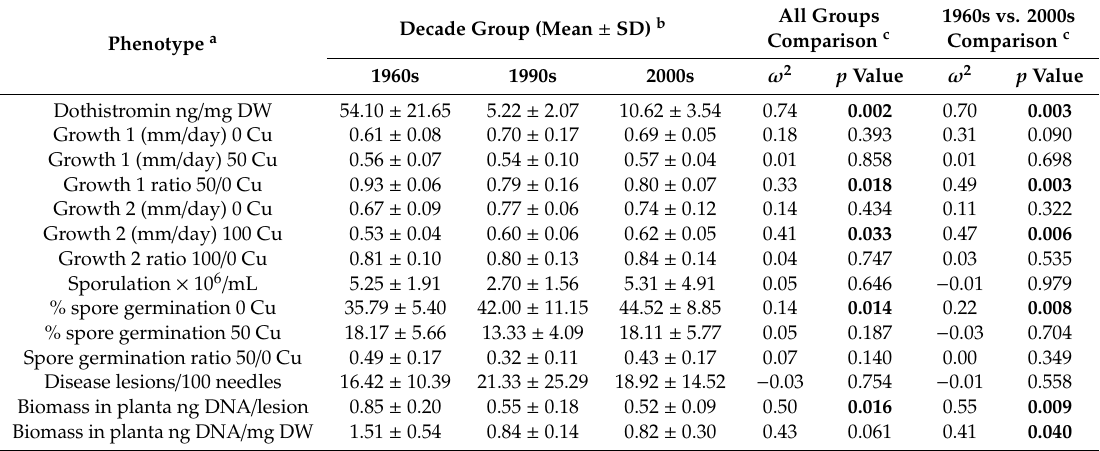
Table 2. Summary of Dothistroma septosporum isolate phenotypes by decade